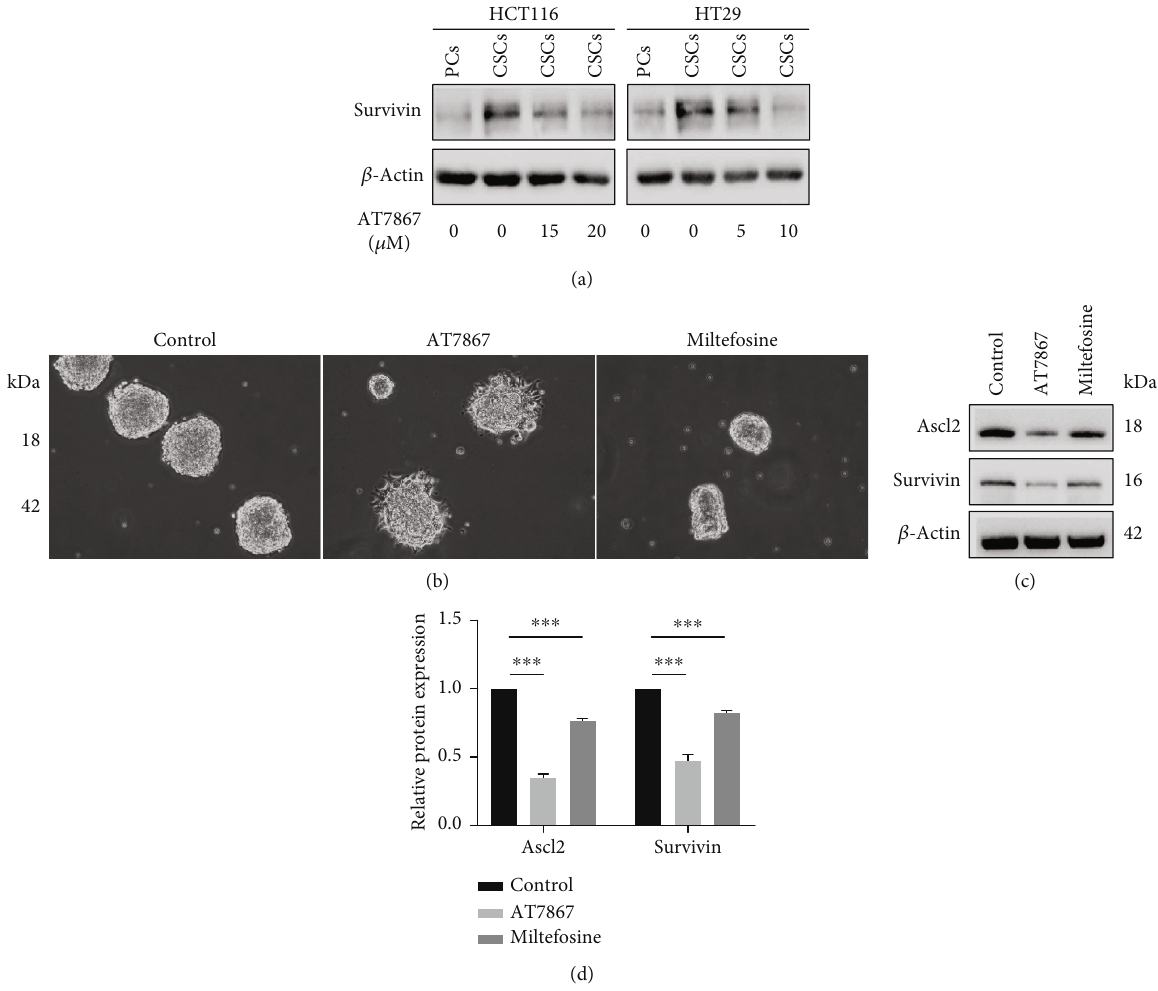
Figure 9: In CRC-derived CSCs, Survivin was activated. compared with the Akt inhibitor miltefosine, AT7867 has a stronger ability to inhibit stemness. (a) Western blot detected the parental cells, the fi fth spheres, and treatment of the fi fth spheres in a di ff erent dose of AT7867 expression of Survivin. (b) Representative morphology after AT7867 and miltefosine treatment. (c) The expression of Ascl2 and Survivin was detected by Western blotting. ∗ P < 0 : 05 , ∗∗ P < 0 : 01 , and ∗∗∗ P < 0 : 001